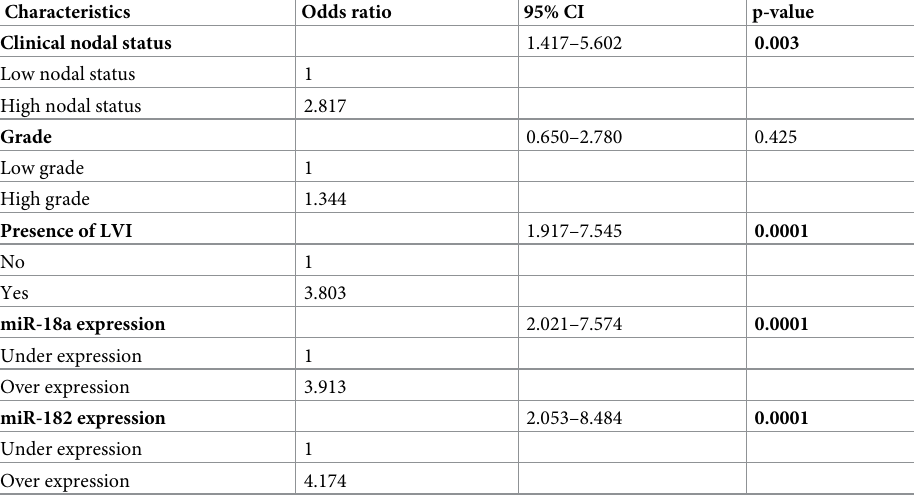
Table 4. Univariate cox proportional hazard regression.